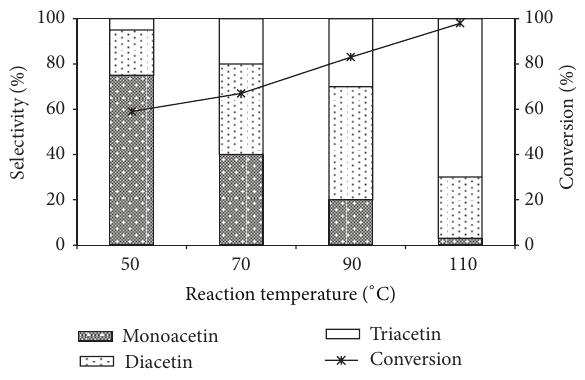
Figure 10: Influence of reaction temperature on glycerol acetylation over WO 3 -Ppy-20 catalysts. (Reaction time: 10h; catalyst weight: 0.4 g; AcOH/Gly mole ratio: 6.)